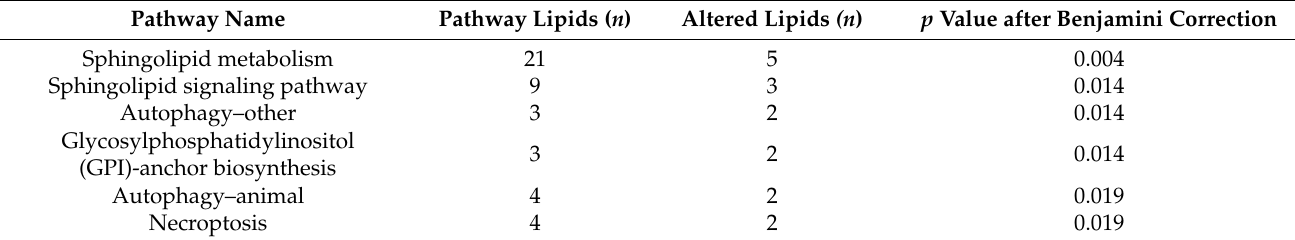
Table 3. Lipid pathways modified by maternal choline supplementation in male offspring mice after 6-week post-weaning high-fat feeding a